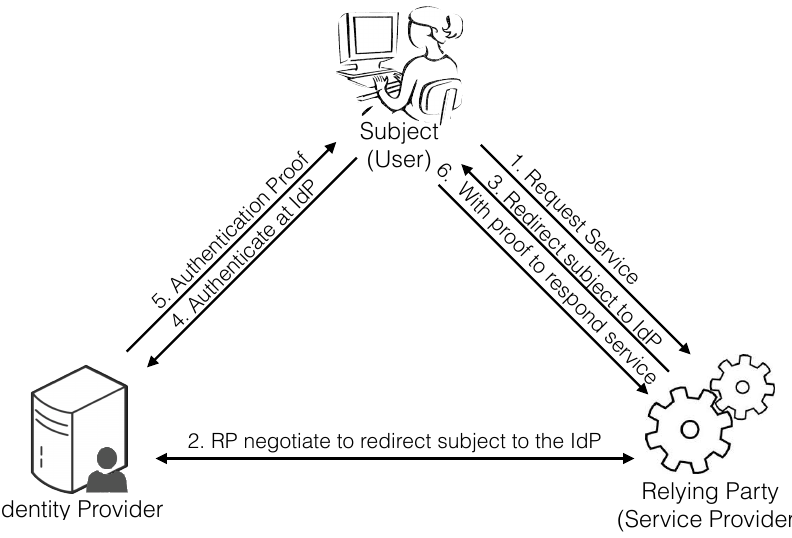
Figure 1. Stakeholders from the traditional IdMS